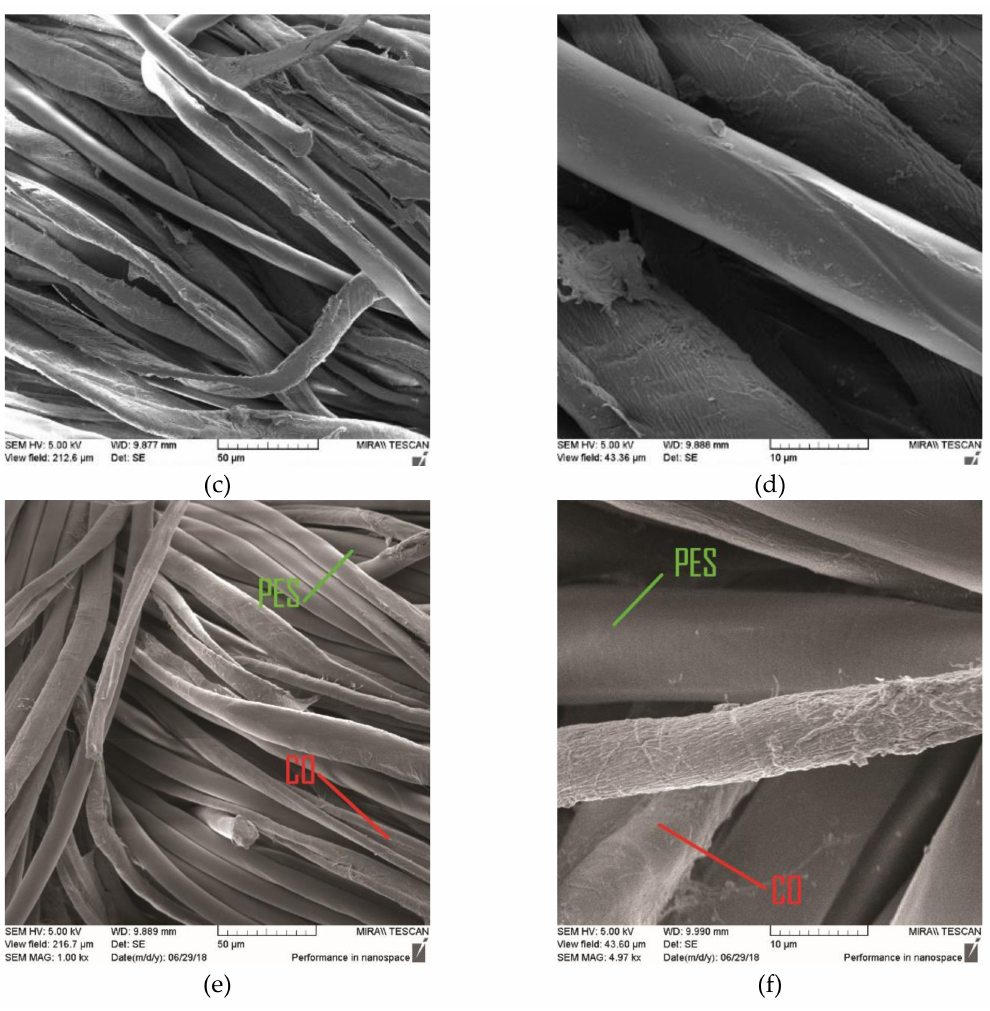
Figure 4. The SEM images of polyester / cotton fabric (PES / CO) with implemented chitosan: ( a , b ) before (PES / CO_Ch); (c , d ) after one washing cycle (PES / CO_Ch_1w) and (e, f) after five washing cycles in magnifications of ( a , c , e ) 1000 × , and (b, d, f) 5000 ×